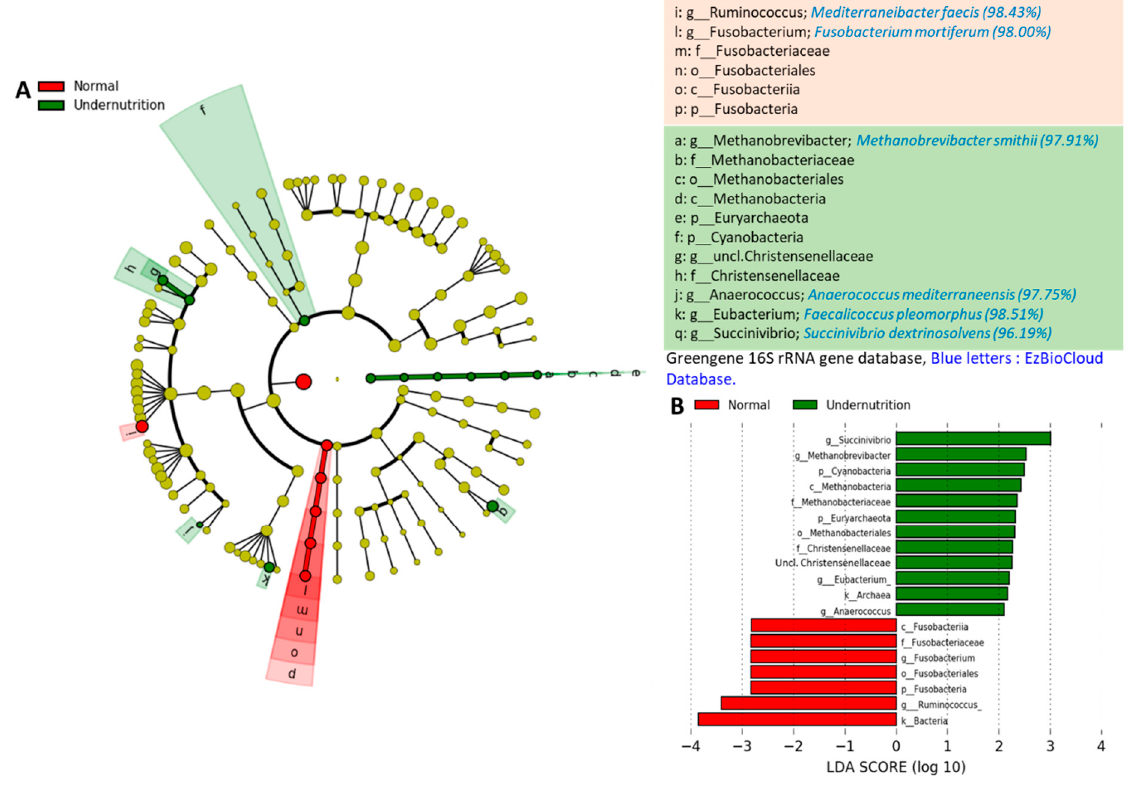
Figure 4. LEfSe showing the difference in gut microbial taxa between the normal and undernutrition group. ( A ) The cladogram shows the difference in gut microbiota between-group; the alphabet indicates the significantly different microbes in each group. Red color refers to the bacteria overexpressed in the normal group, and green color refers to the bacteria overexpressed in the undernutrition group. ( B ) Histogram of LDA score of gut microbiota between-group. Bar length represents the effect size, which explains the differentiating phenotypes between groups. k__, domain; p__, phylum; c__, class; o__, order; f__, family; g__,